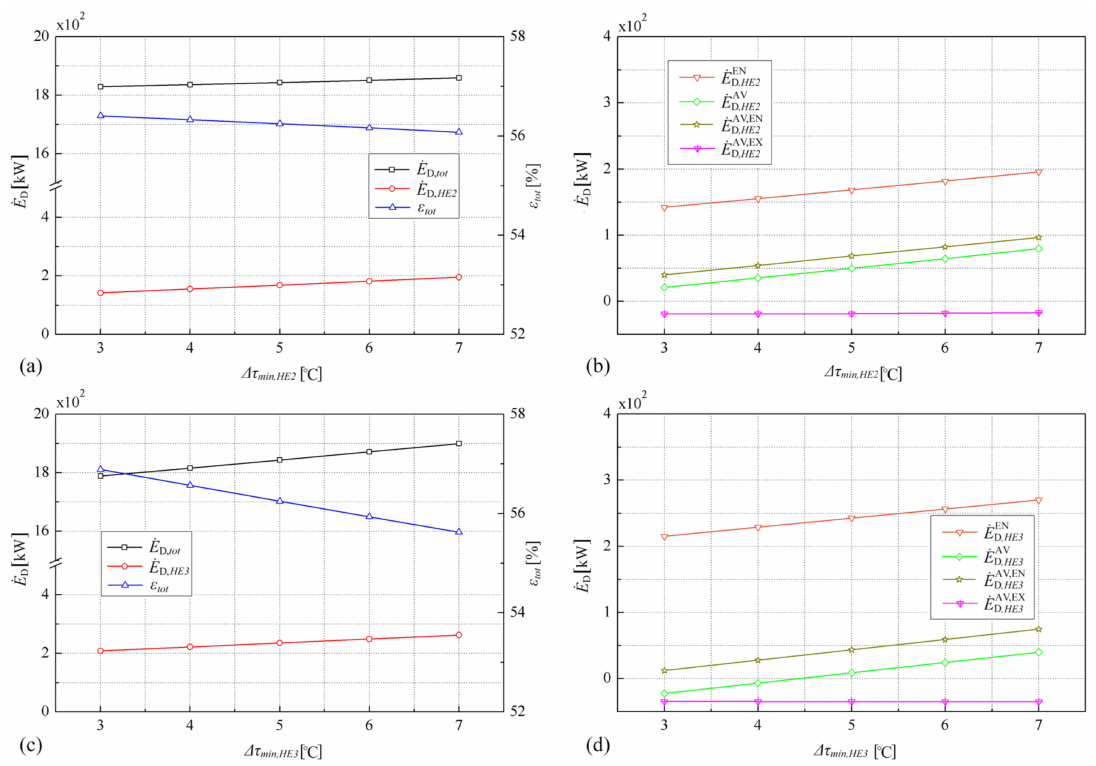
Figure 5. E ff ects of pinch temperature in heat exchangers: ( a ) conventional and ( b ) advanced exergy analysis results versus pinch temperature in heat exchanger 2; ( c ) conventional and ( d ) advanced exergy analysis results versus pinch temperature in heat exchanger